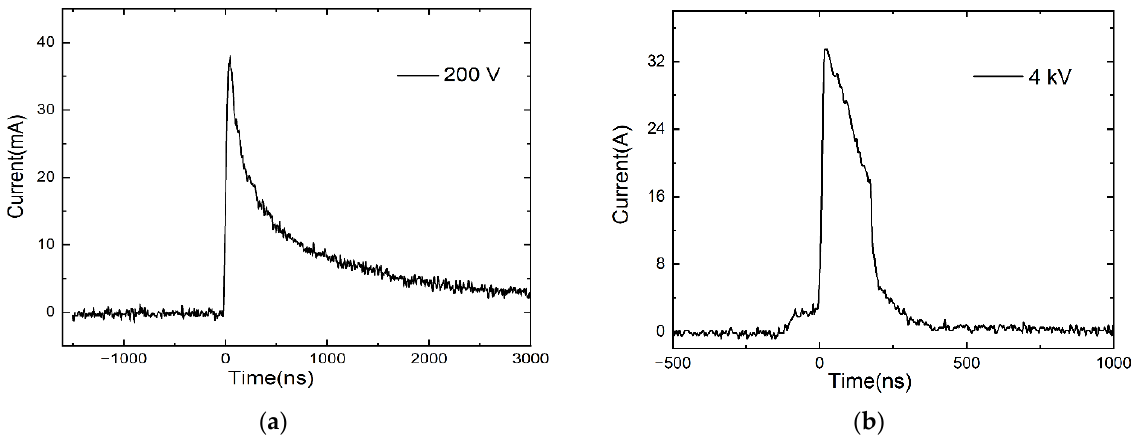
Figure 8. Current waveform of the switch triggered by pulsed spark discharge radiation, with a 4 nF capacitor. ( a ) The GaAs PCSS operating at a bias voltage of 200 V. ( b ) The GaAs PCSS operating at a bias voltage of 4 kV.